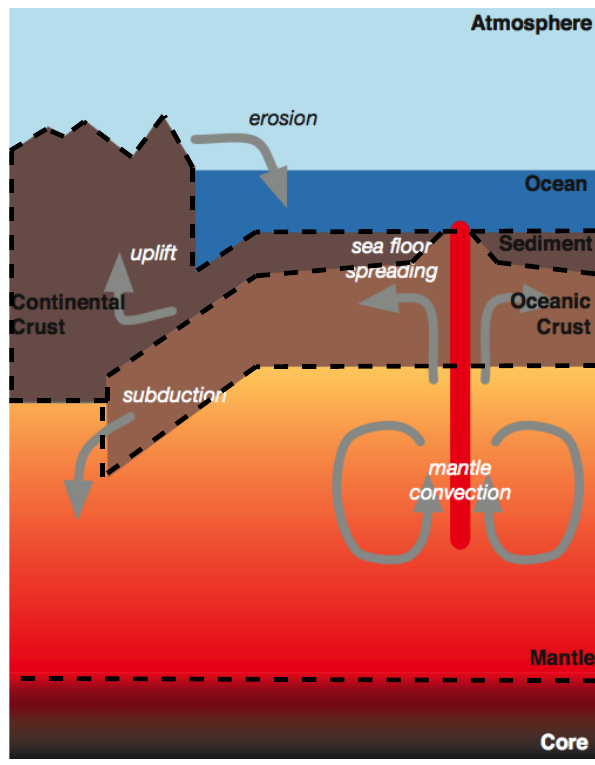
Fig. 3. The rock cycle’s major components of: mantle convection, oceanic crust recycling and continental crust recycling are shown. The subsystem boundaries are delineated with dashed black